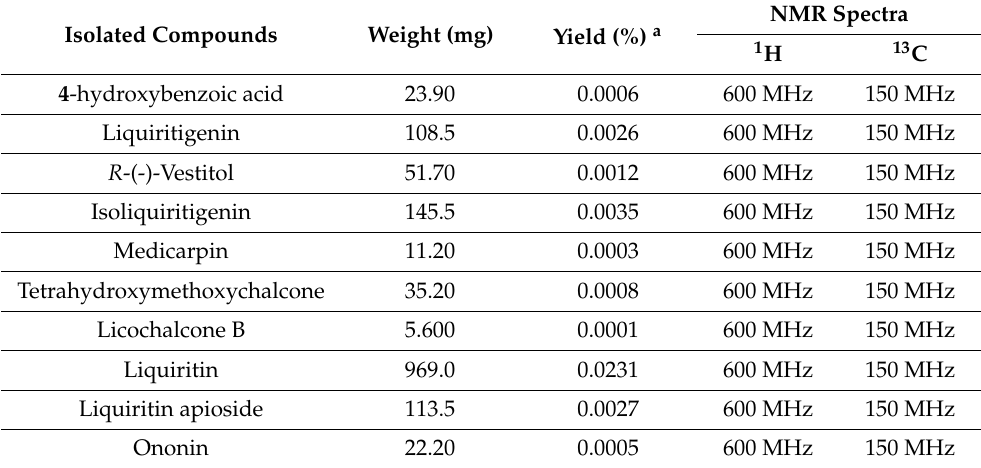
Table 1. Compounds in the G. uralensis –EtOAc